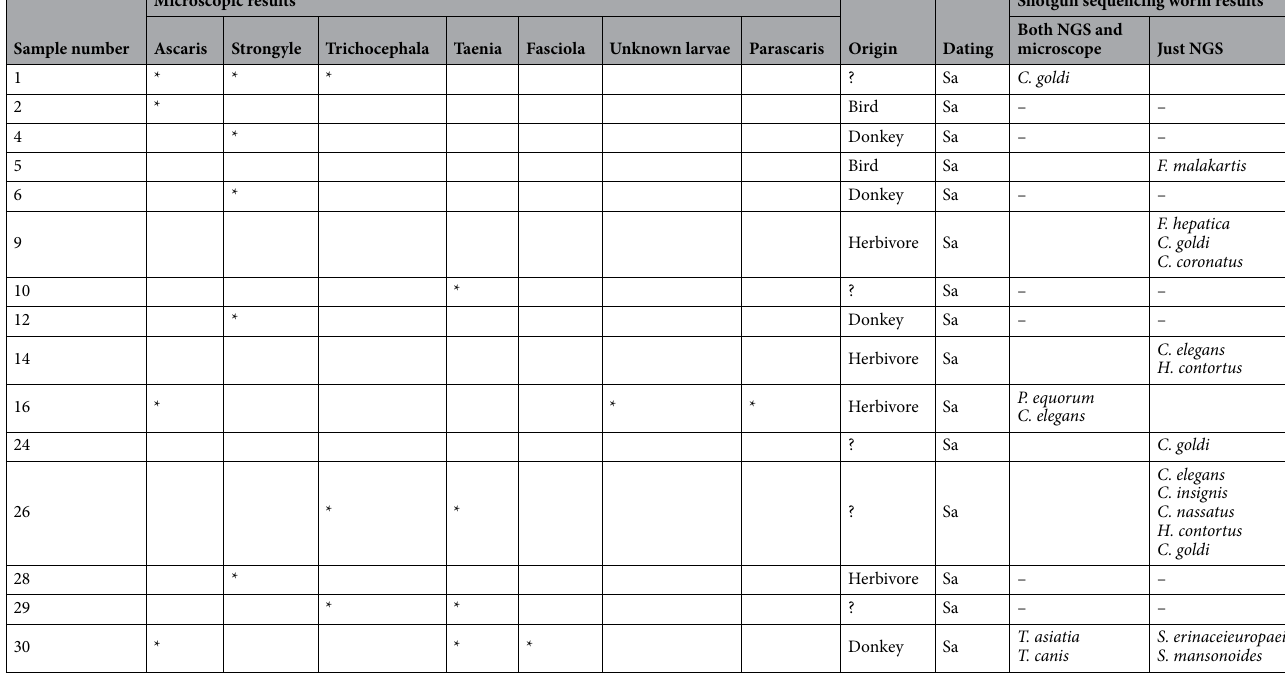
Table 1. Microscopic & Shotgun sequencing results, botanic origin and dating of fifteen positive